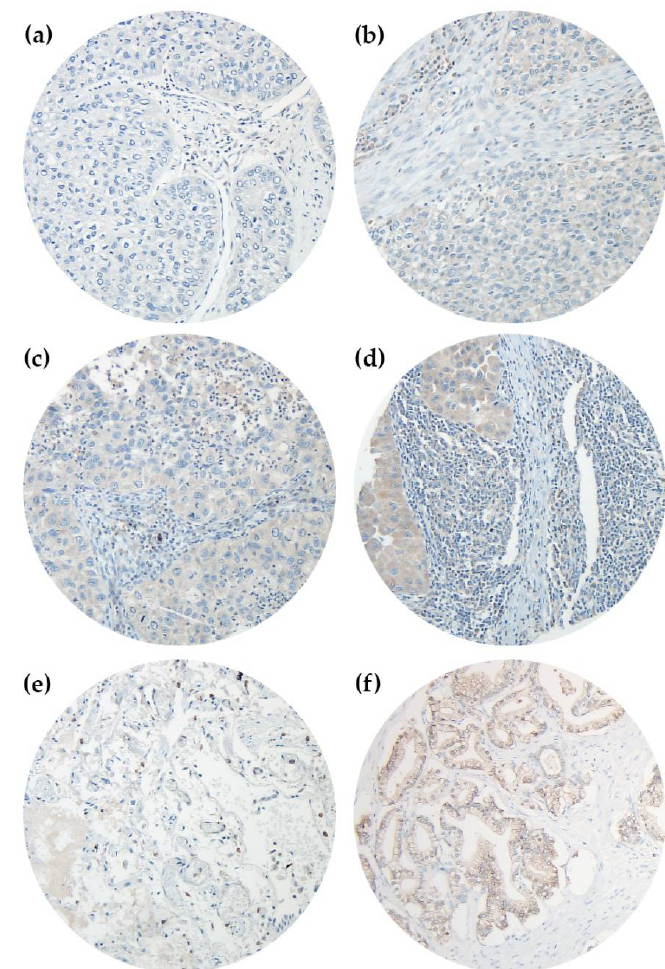
Figure 1. Immunohistochemistry of NT5DC2 in NSCLC TMAs. Primary antibody was Atlas Antibodies HPA050683 rabbit polyclonal IgG anti-NT5DC2 antibody, Secondary antibody was Roche/Ventana 760-700 OptiView DAB IHC Detection Kit. Analyses were performed on an Olympus BX51